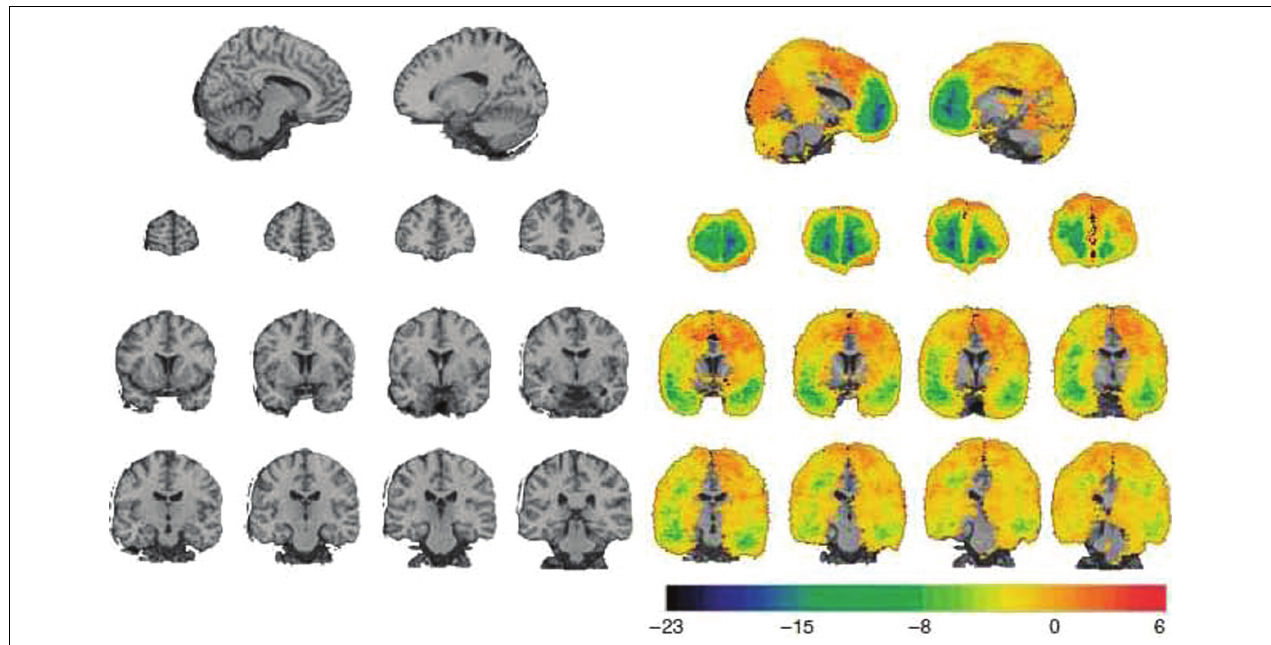
hemisphere ( x = 16) is on the right. Second row, coronal views of negative value clusters in bilateral prefrontal cortex. Slices are arranged with the anterior most slice on the left ( y = 66, y = 56, y = 36, respectively). In each coronal slice, the right hemisphere is on the reader’s left (radiological convention).Third row, coronal views of negative value clusters in bilateral anterior temporal lobe ( y = 14, y = 8, y = 2, y =− 4, respectively). Fourth